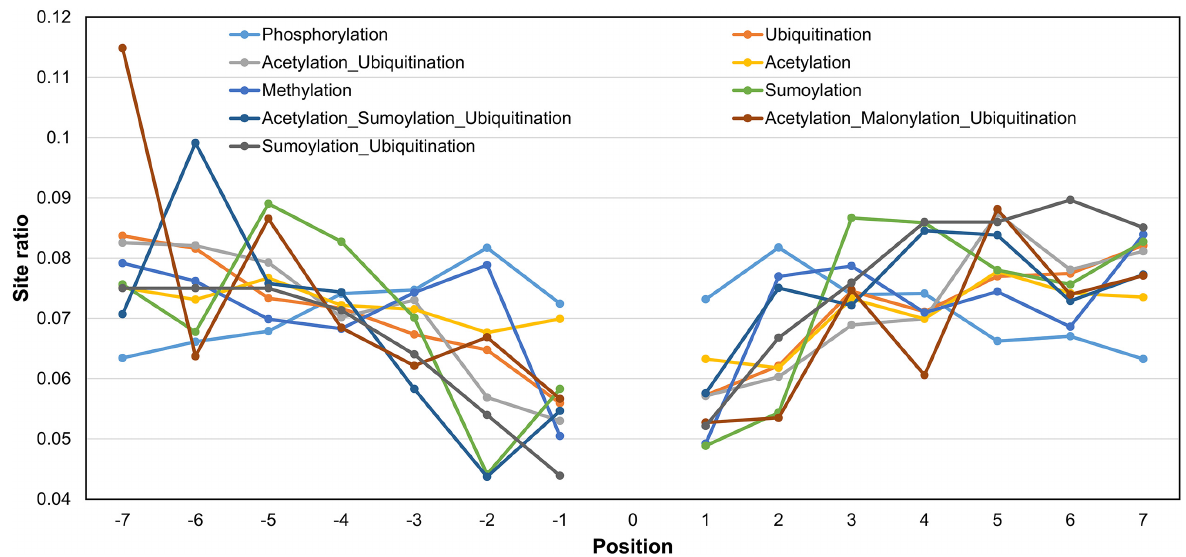
FIGURE 4 | Fraction of sites around the central position for various PTMs and their in situ crosstalks. The x -axis represents the PTM motif position, and y -axis represents the ratio of sites present on that position with respect to the total number of sites for a particular PTM/crosstalk excluding the central site. While phosphorylation tends to decrease with distance from center, acetylation, ubiquitination, and their combination follow opposite trend. The competition between acetylation–malonylation and ubiquitination shows a preference for -7 position, whereas competition between acetylation, sumoylation, and ubiquitination shows preference for -6 position in the